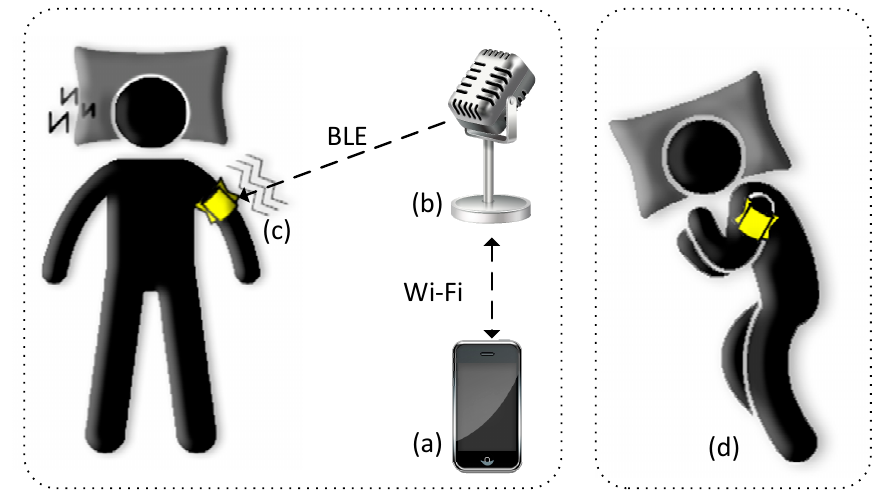
Figure 1. The proposed snoring detection and vibration notification system. The user configures the system and starts a snoring session using the smartphone app ( a ) – which connects with the listener module using Wi-Fi. The listener module ( b ) detects snoring sound and sends command using Bluetooth low energy (BLE) to the wearable gadget ( c ) to generate vibration notification to the snorer. Snoring events with a timestamp are logged in smartphone ( a ). The vibration stops automatically after the snorer changes sleeping position to the side ( d ).